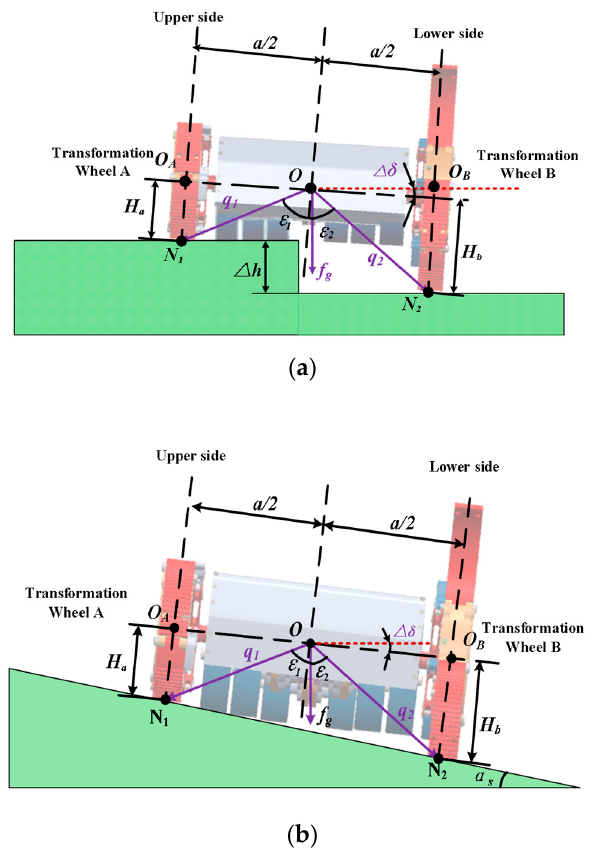
Figure 15. Stable cone model for unilateral expansion of transformed wheels. ( a ) Vertical obstacle; ( b ) sloping terrain.